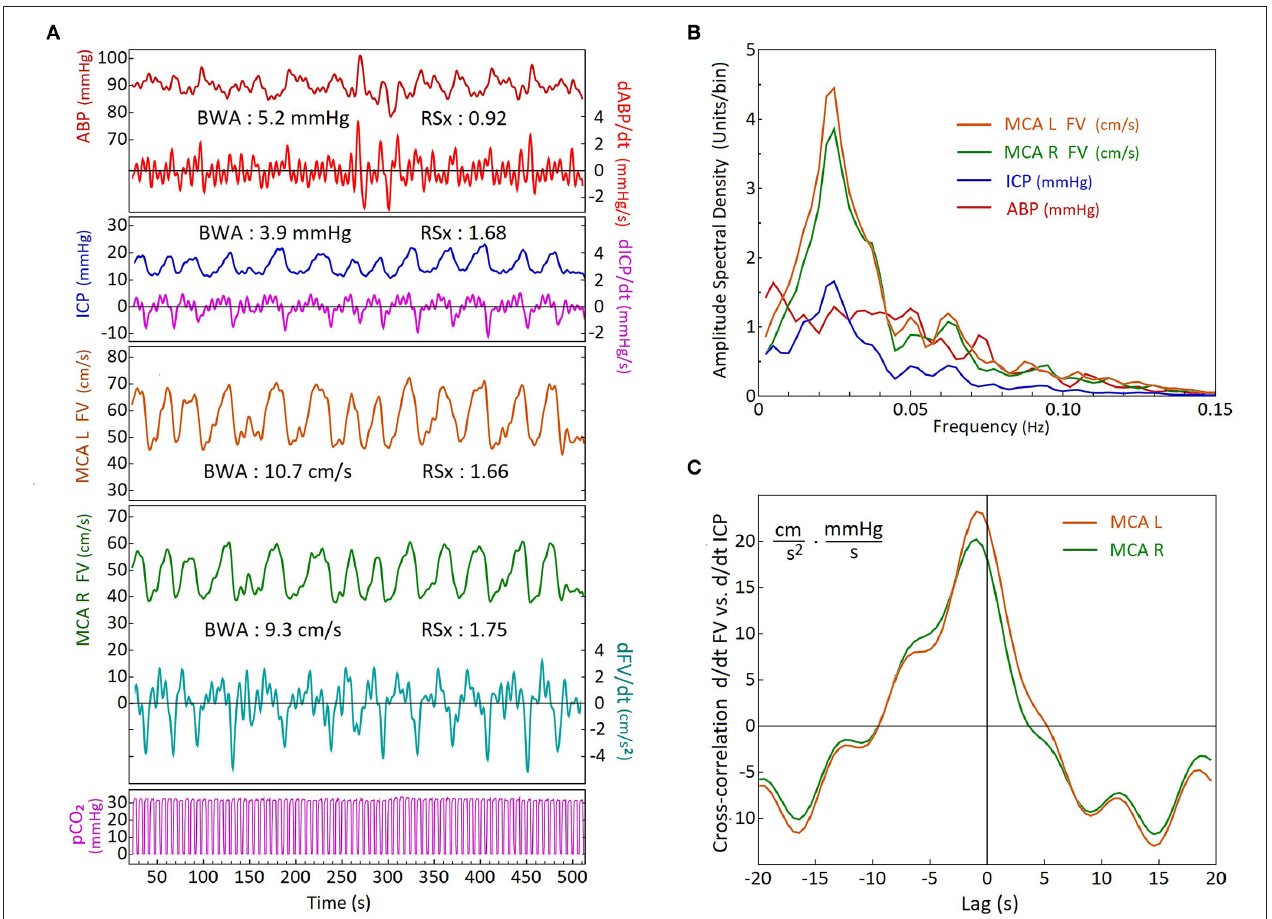
FIGURE 2 | Comparison of activity and timing of simultaneous blood pressure, flow velocity, intracranial pressure and end tidal CO 2 recordings during B waves, using frequency analysis and cross-correlation. (A) Time-series recordings from a head trauma patient on Day 5, showing arterial blood pressure (ABP), intracranial pressure (ICP), bilateral middle cerebral artery (MCA) flow velocities (FVs), and airway partial CO 2 pressure (pCO 2 ). The time-derivative series of Right FV, ICP and ABP are also shown. The ramp symmetry indices (RSx’s) were calculated from the time-derivative series (labels on right). Note that the ICP and the FV’s have similar waveform asymmetry and higher Rsx values > 1(faster down than up) whilst the ABP RSx indicates slightly faster up than down with an Rsx value < 1. A double peak wave morphology is demonstrated by the right MCA flow velocity tracing in green between the 200 and 250 second mark. (R, right; L, left); (B) Results of spectral analysis using discrete Fourier transforms of the time-series data in (A) . The amplitude spectral density curves are similar for the FVs and the ICP, showing distinct peaks within the B wave frequency range. The ABP amplitude spectral density curve has a different shape with a much flatter distribution over most of the frequency range (as in the composite of the group shown in Figure 3A ); (C) Cross-correlation analysis of dFV/dt versus dICP/dt. There is only a small difference in amplitude between the sides which is probably due to the mean FV of the left MCA being slightly higher. For both sides, the dFV/dt leads the dICP/dt by approximately 1 sec.